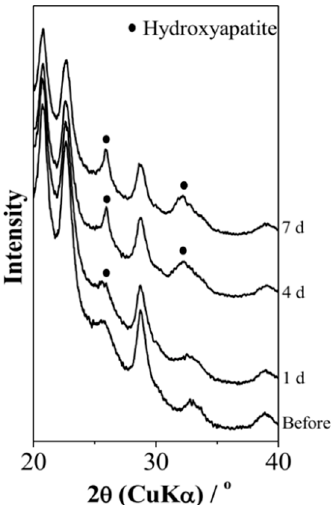
Figure 4. TF-XRD profiles of on the surface of Sample SGA before and after immersion in SBF for 1 day, 4 days and 7 days.